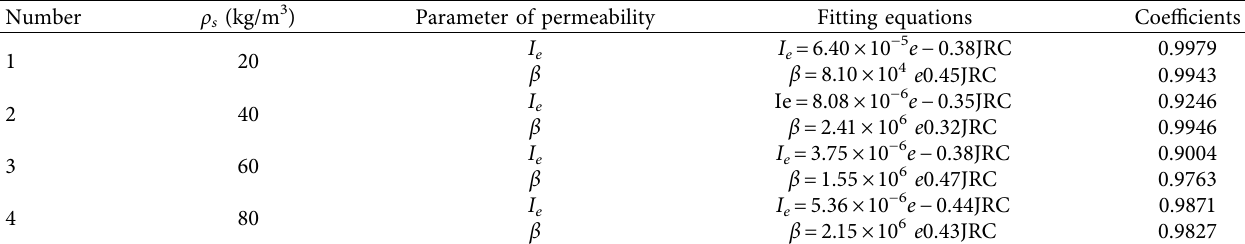
� 0.061 ∼ 0.080mm. s